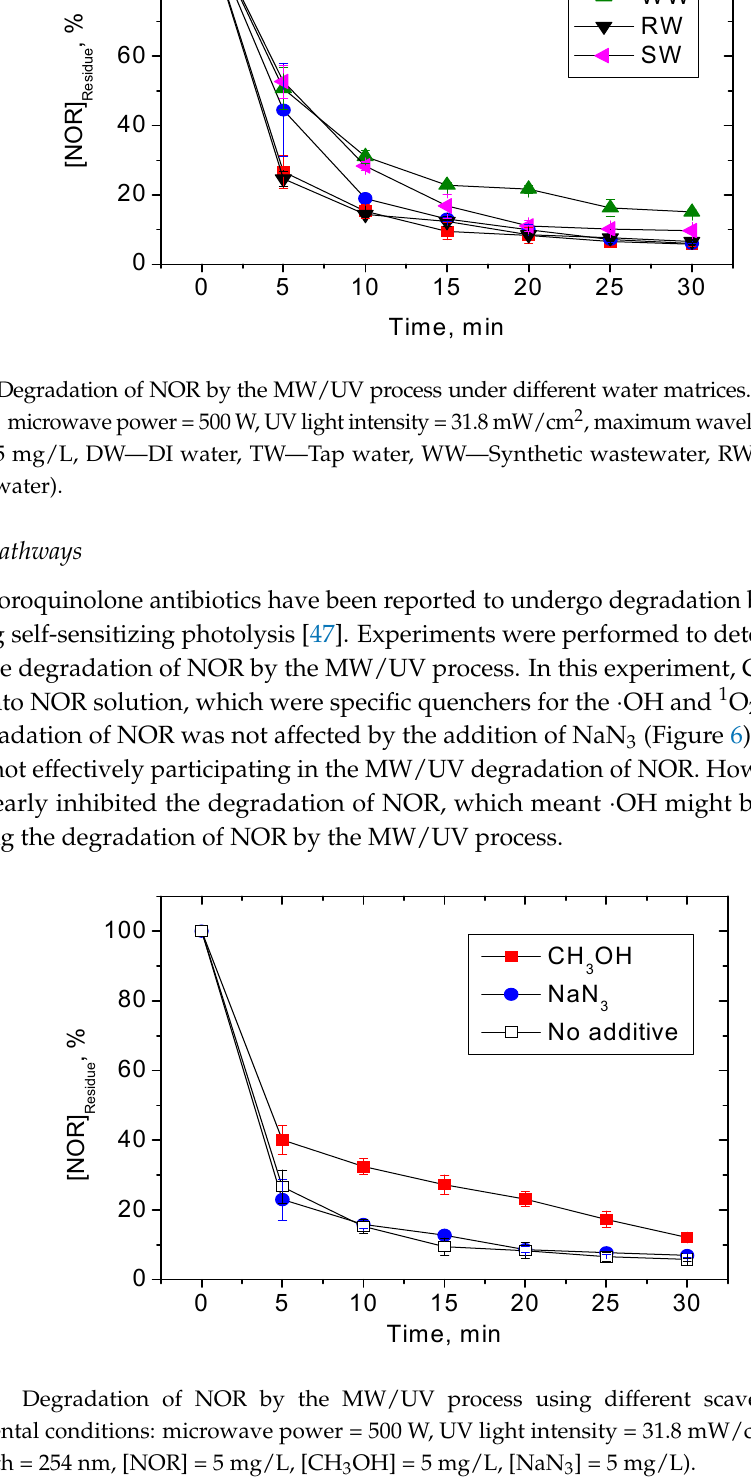
Table 5. The information of intermediates formed in the MW/UV degradation of NOR.